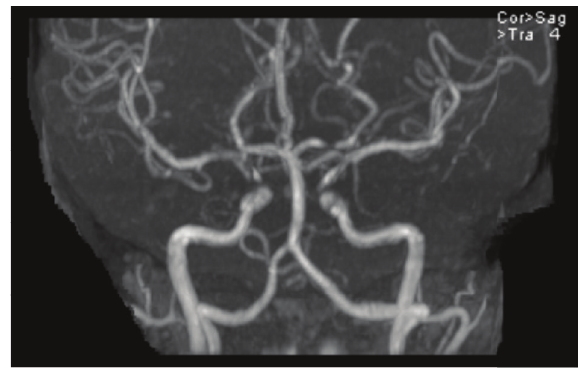
Figure 3: MRA: diminished flow in anterior division of left middle cerebral